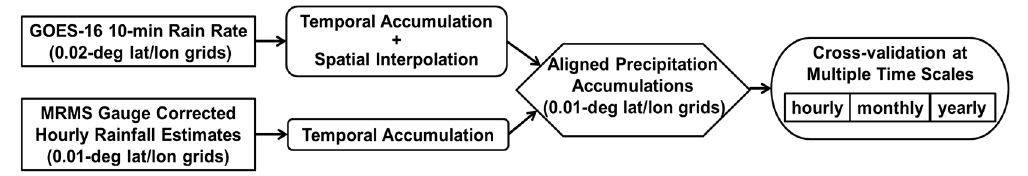
Figure 2. Simplified flow chart of the space–time alignments of the GOES ‐ 16 QPE and GC ‐ MRMS data.